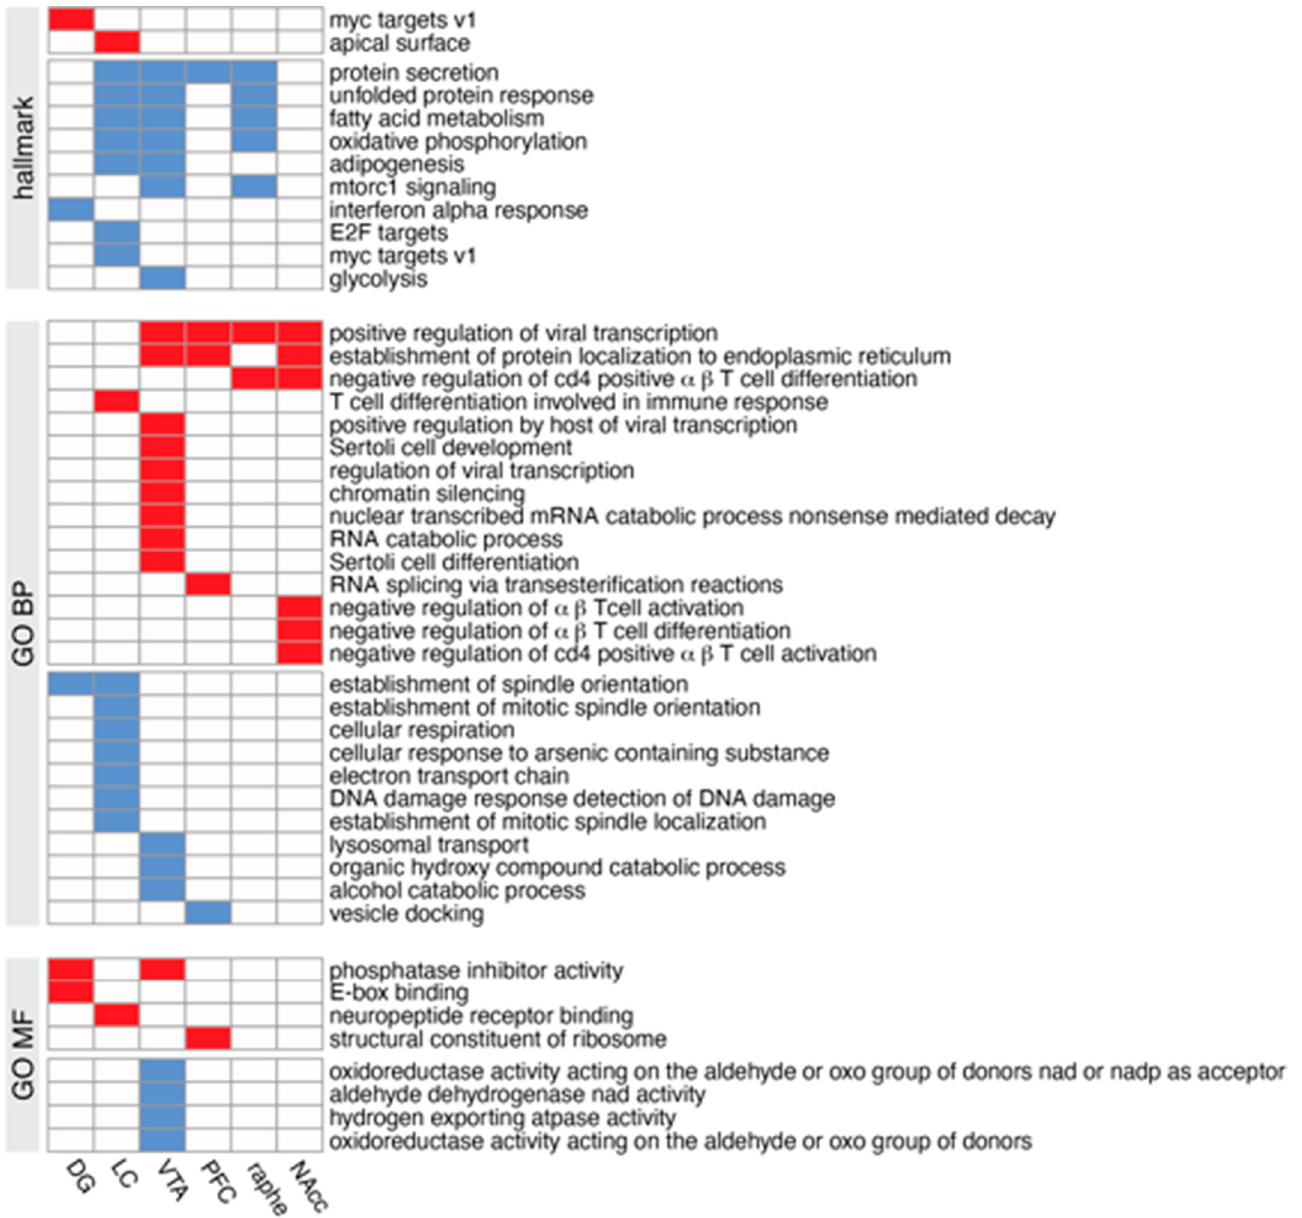
Figure 9. Enriched gene sets across individual brain regions. Enriched (over-represented) gene Scheme 2. DBHCre KO are shown in red; enriched gene sets with down-regulated genes in VMAT2 DBHCre KO are shown in blue.